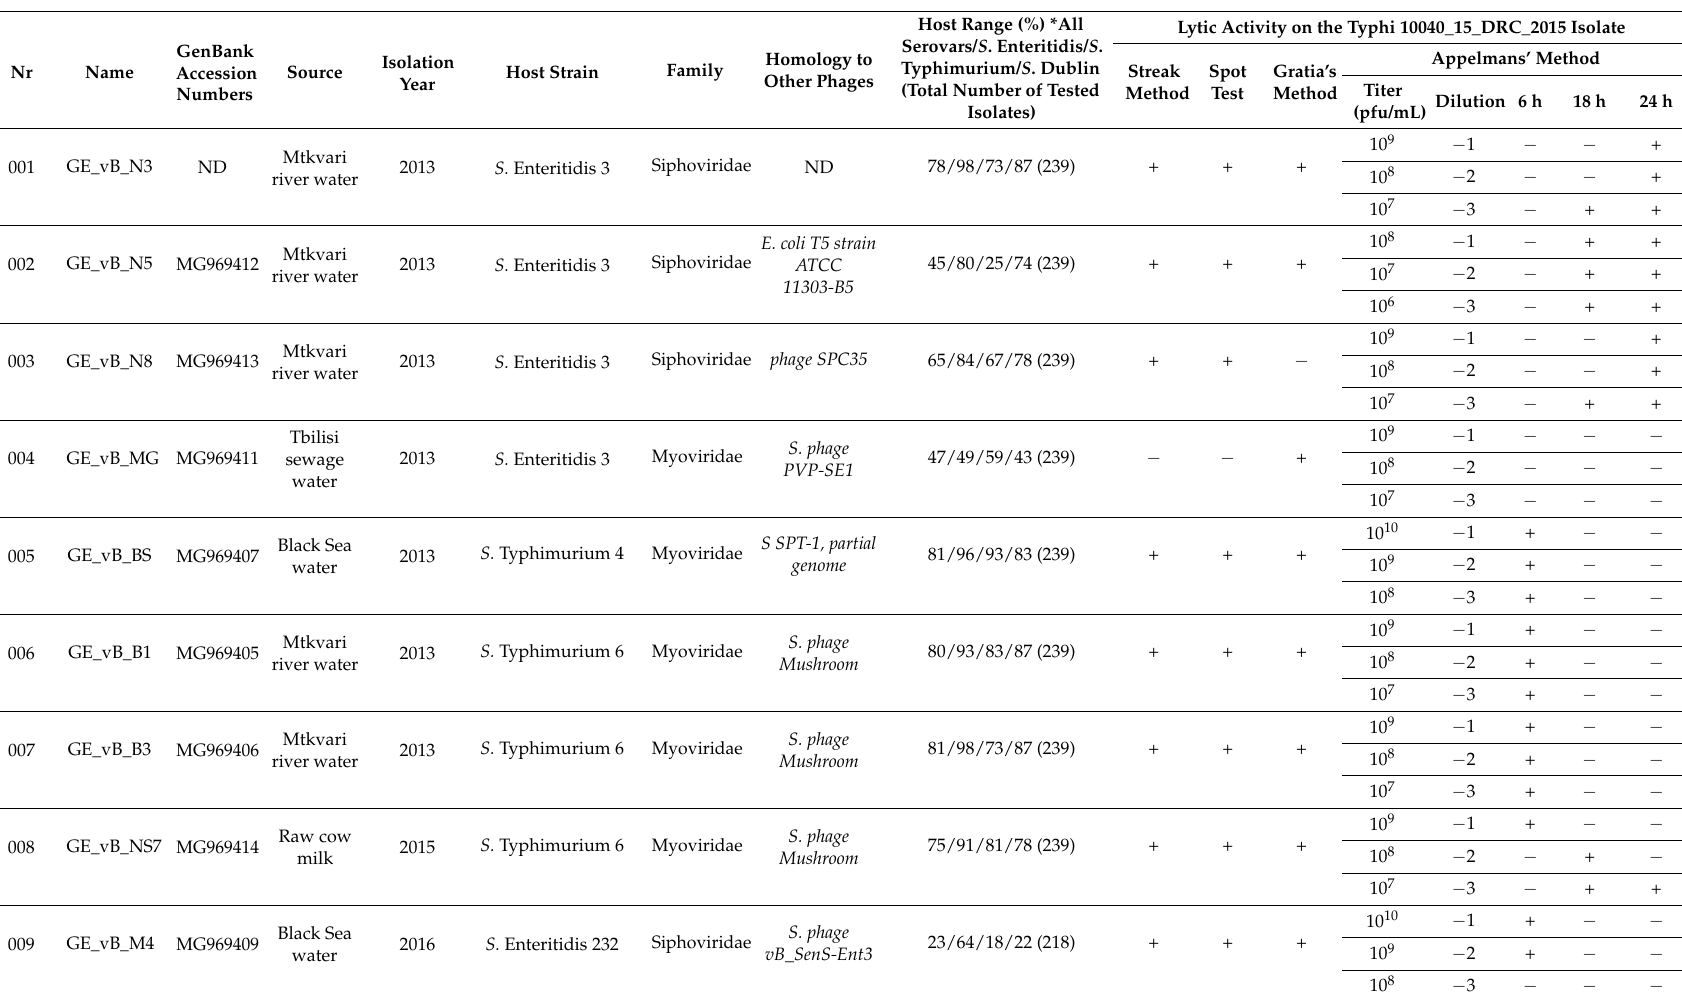
Table 1. Characteristics of 14 Salmonella phages from the Eliava collection tested on the Typhi 10040_15_DRC_2015 isolate from the Democratic Republic of the Congo